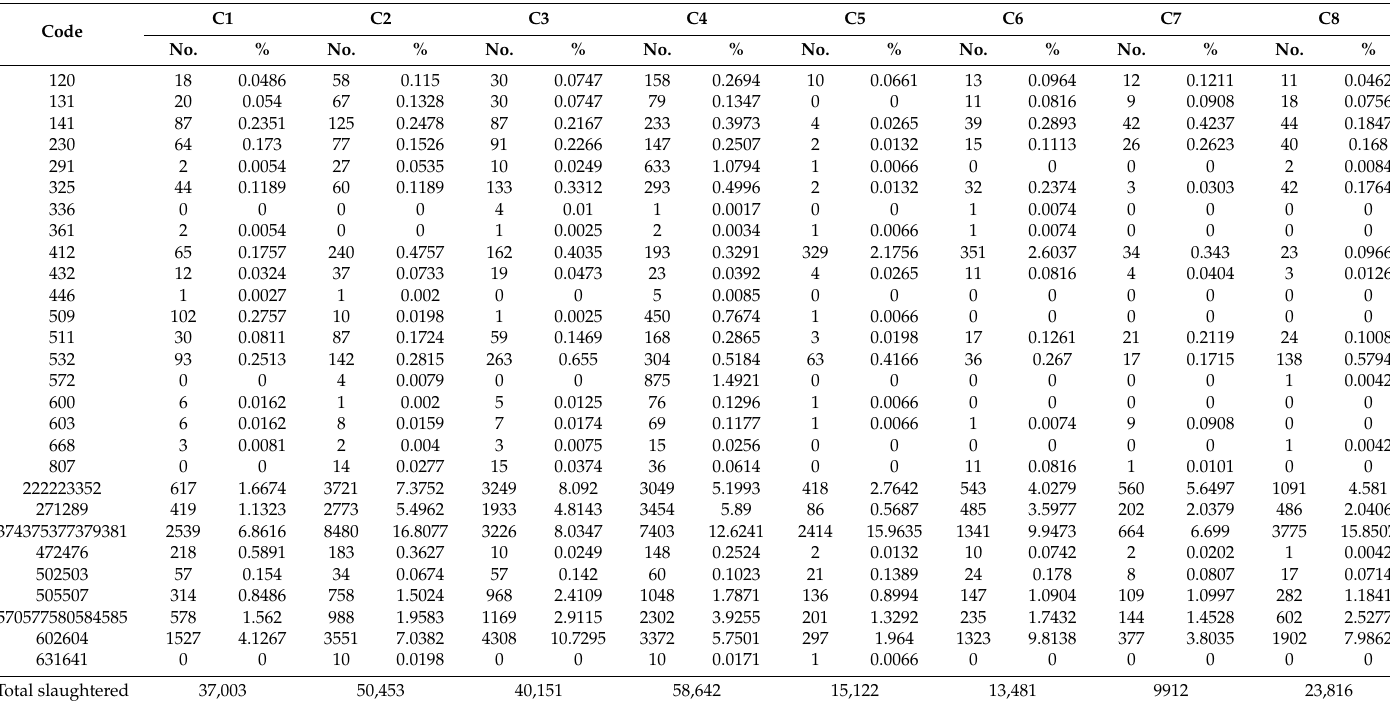
Table 4. Prevalence of selected slaughter recording codes or combinations (“code”) in 248,580 cattle ≥ 18 months of age slaughtered at the eight largest cattle slaughterhouses (C1–C8) in